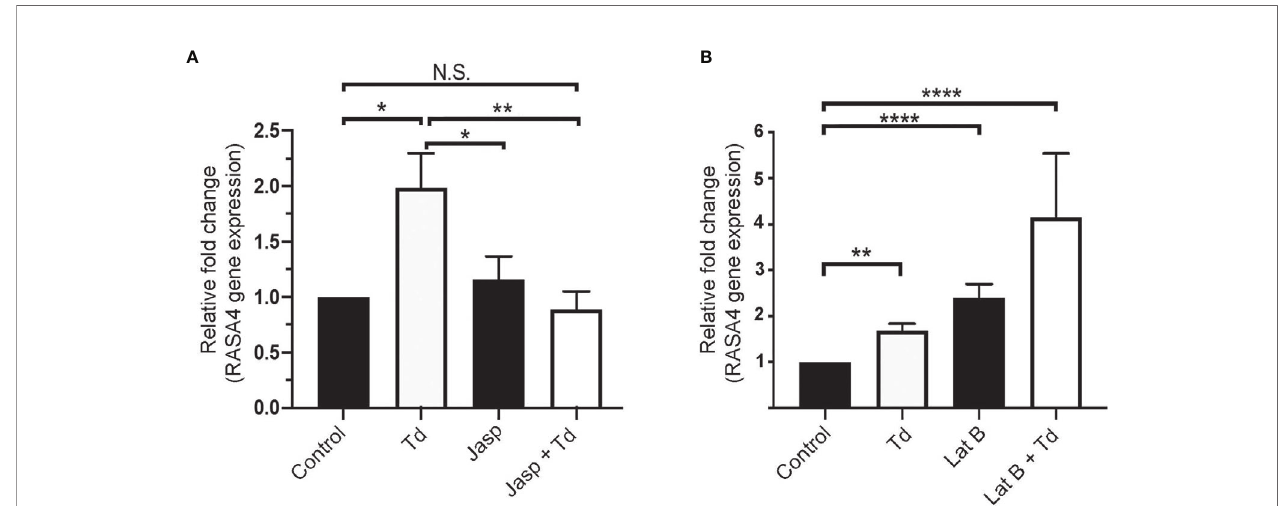
FIGURE 5 | Jasplakinolide inhibited T. denticola -induced RASA4 gene expression, whereas RASA4 gene expression is upregulated in Latrunculin B pretreated and T. denticola challenged PDL cells. Quantitative RT-PCR analysis of RASA4 relative fold change in the gene expression of PDL cells treated with Jasplakinolide (Jasp; panel A ) or Latrunculin B (Lat B; panel B ) and challenged with T. denticola (50 MOI). Data represent mean ± SD from three independent experiments. Data were compared using Two-way ANOVA Tukey ’ s Multiple comparisons test. * = p<0.05; ** = p<0.01; **** = p<0.0001; N.S., not signi fi cant.